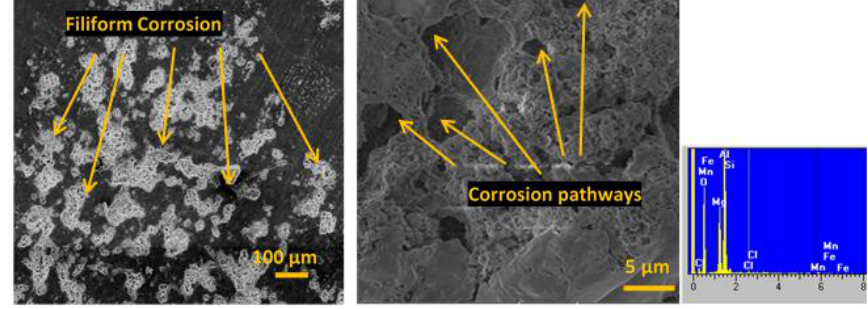
Fig. 8. SEM image after electrochemical